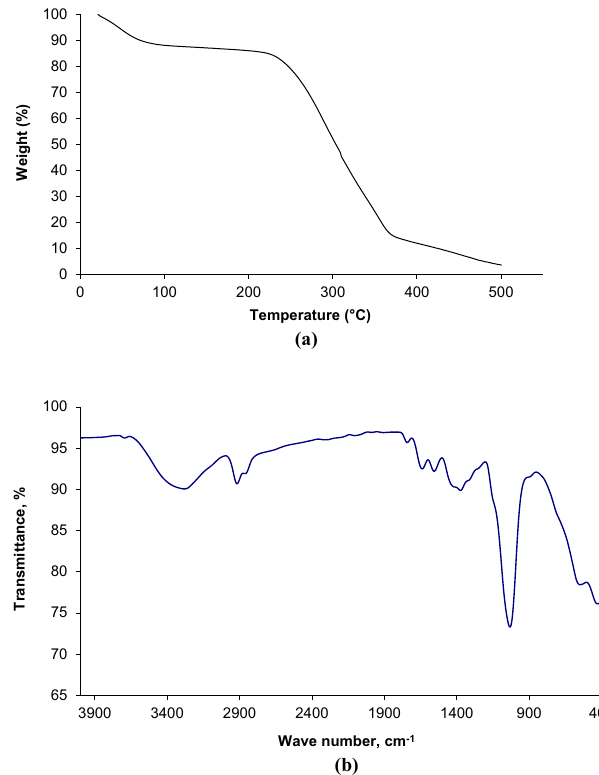
Figure 9. Characterization of produced BC ( a ) Thermal gravimetric analysis; ( b ) FTIR